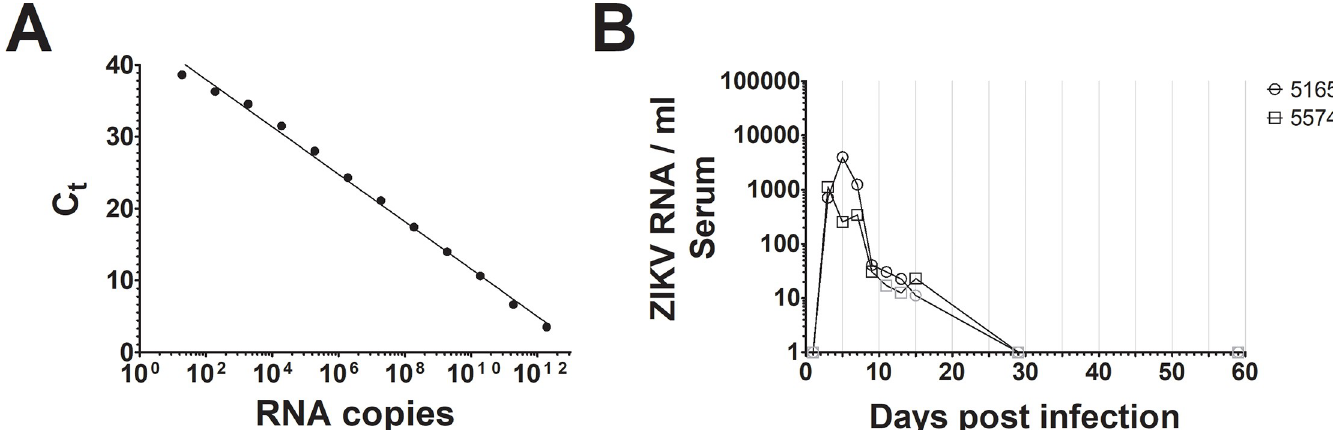
Fig 2. (A) A representative standard curve for ZIKV detection by RT-qPCR. A portion of the ZIKV NS5 gene synthesized in vitro was used to generate a RT-qPCR standard curve using SYBR-Green. A non-linear regression was used to determine correlation (R 2 = 0.99). (B) RNA was extracted from the serum sampled from two experimentally infected non-human primates over time, and ZIKV was quantified using RT-qPCR. ZIKV was detected between 3–15 dpi. Gray symbols indicate ZIKV at levels outside the range of the standard curve. No ZIKV was detected at 59 dpi.